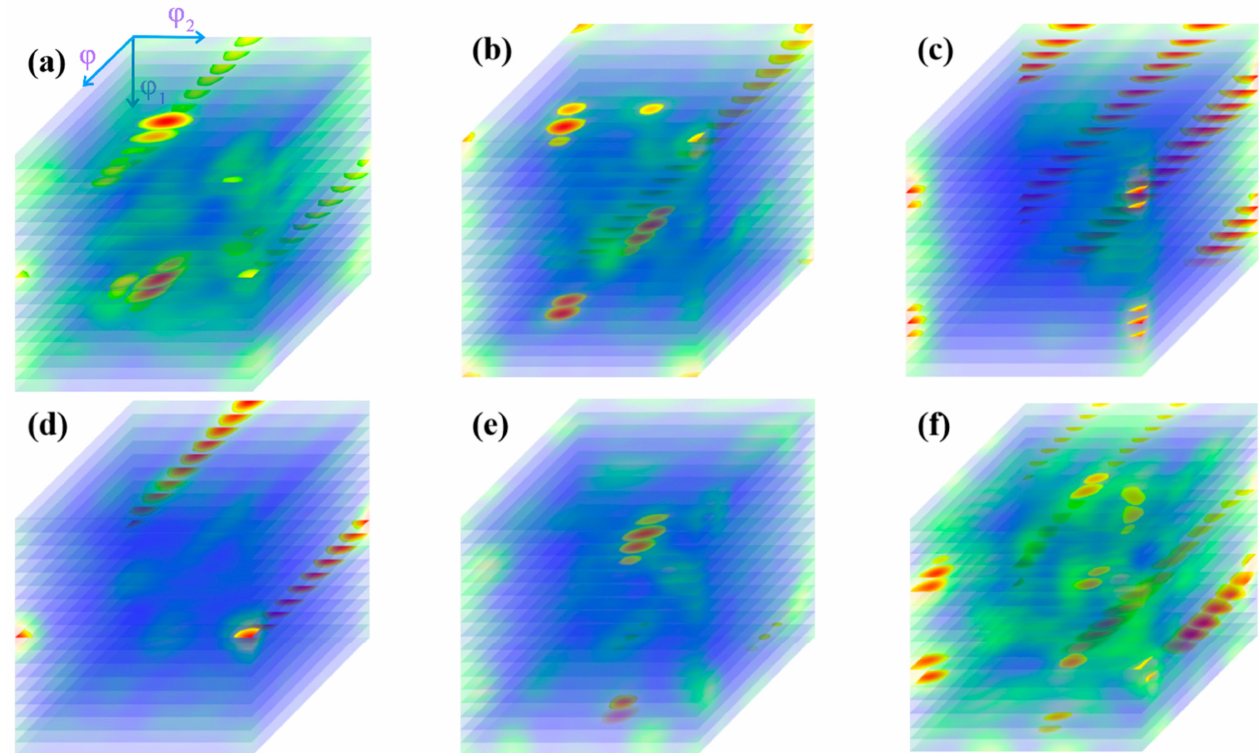
Figure 11. ODF of FCEed sample at the processing temperature of 150 ◦ C: ( a ) 250 µ m from the edge, ( b ) 1 mm from the edge, ( c ) 2 mm from the edge, ( d ) 4 mm from the edge and ( e , f ) 250 µ m from the